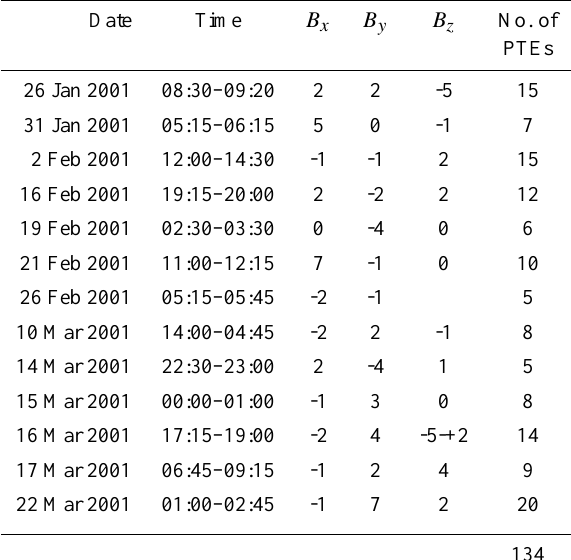
Table 1. Plasma Transfer Events detected by Cluster